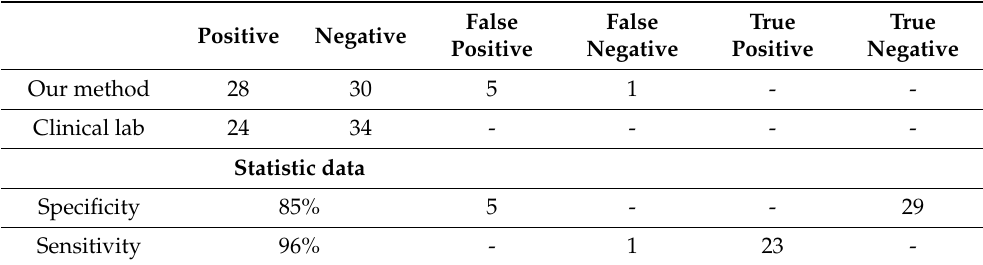
Table 3. Results obtained from the analysis of urine samples. Comparison with the method performed in a clinical laboratory.